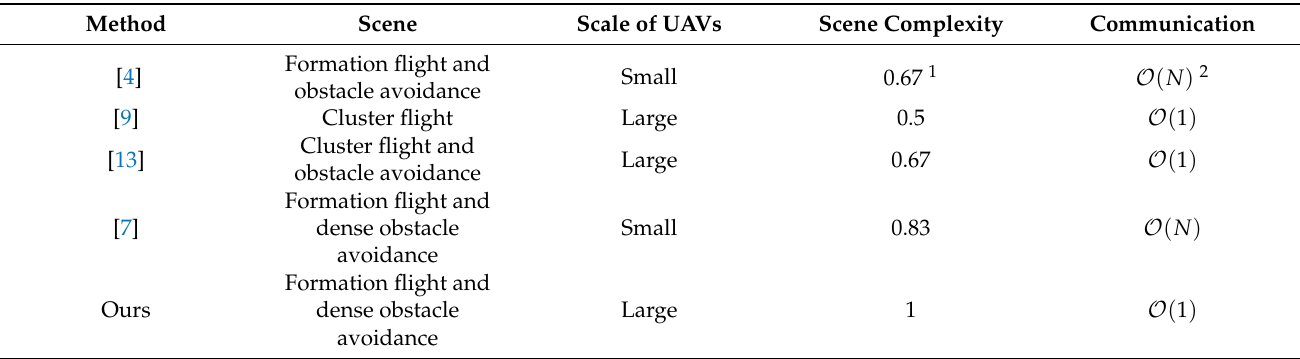
Table 2. Comparison with baseline